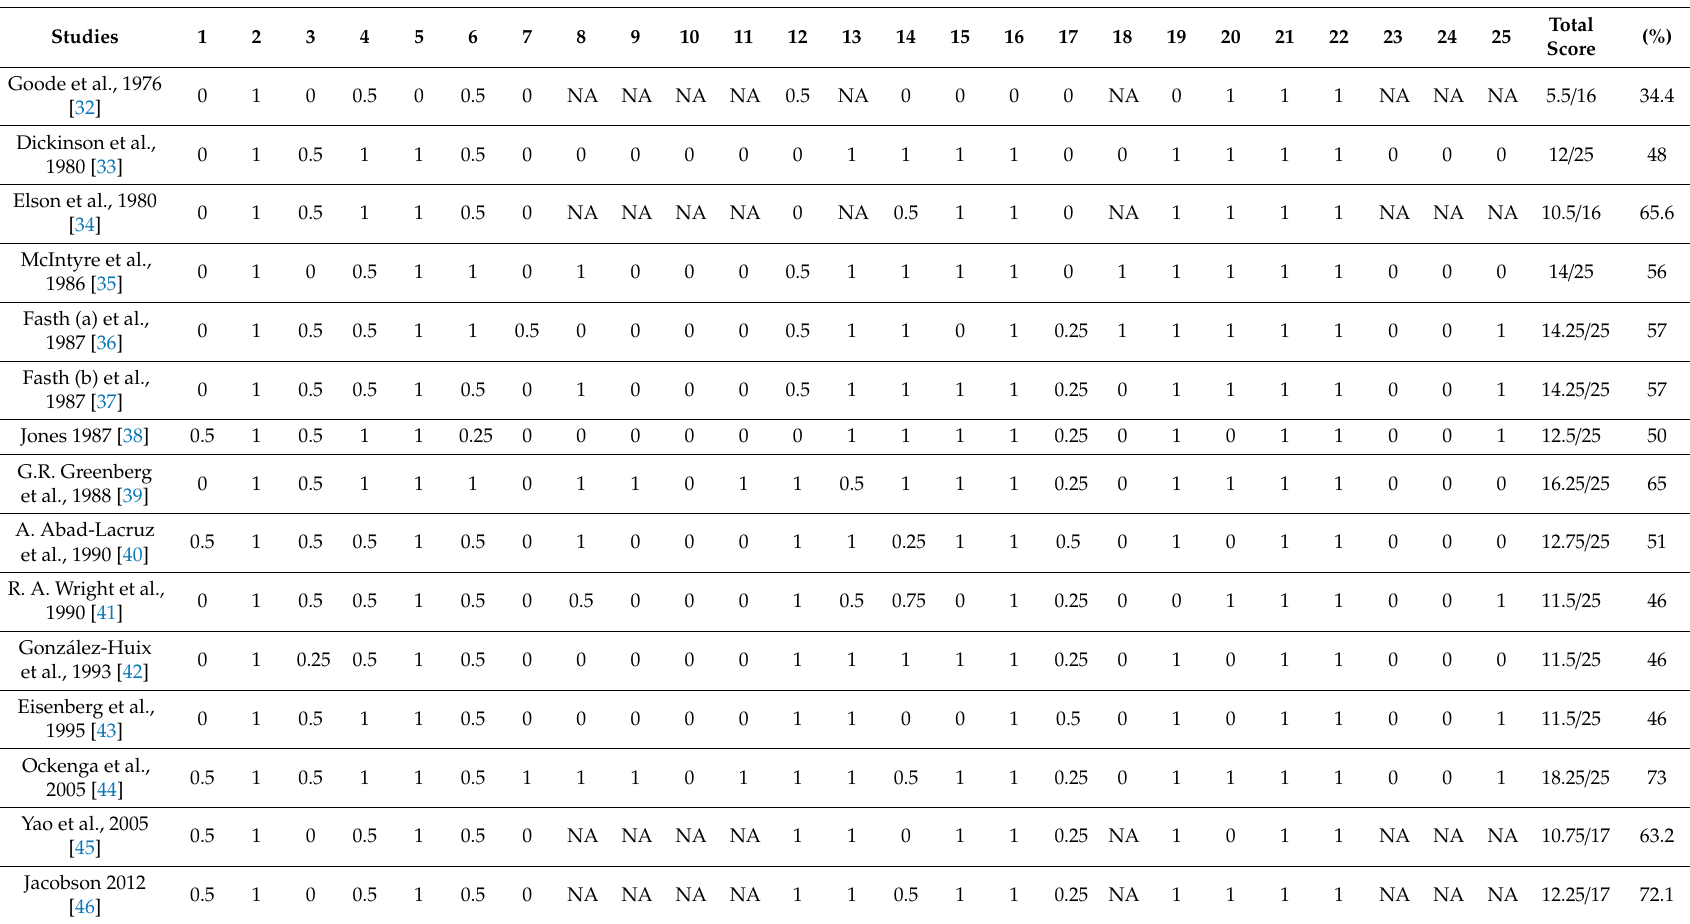
Table 2. Methodological quality analysis according to the CONSORT guide [25] for reporting clinical